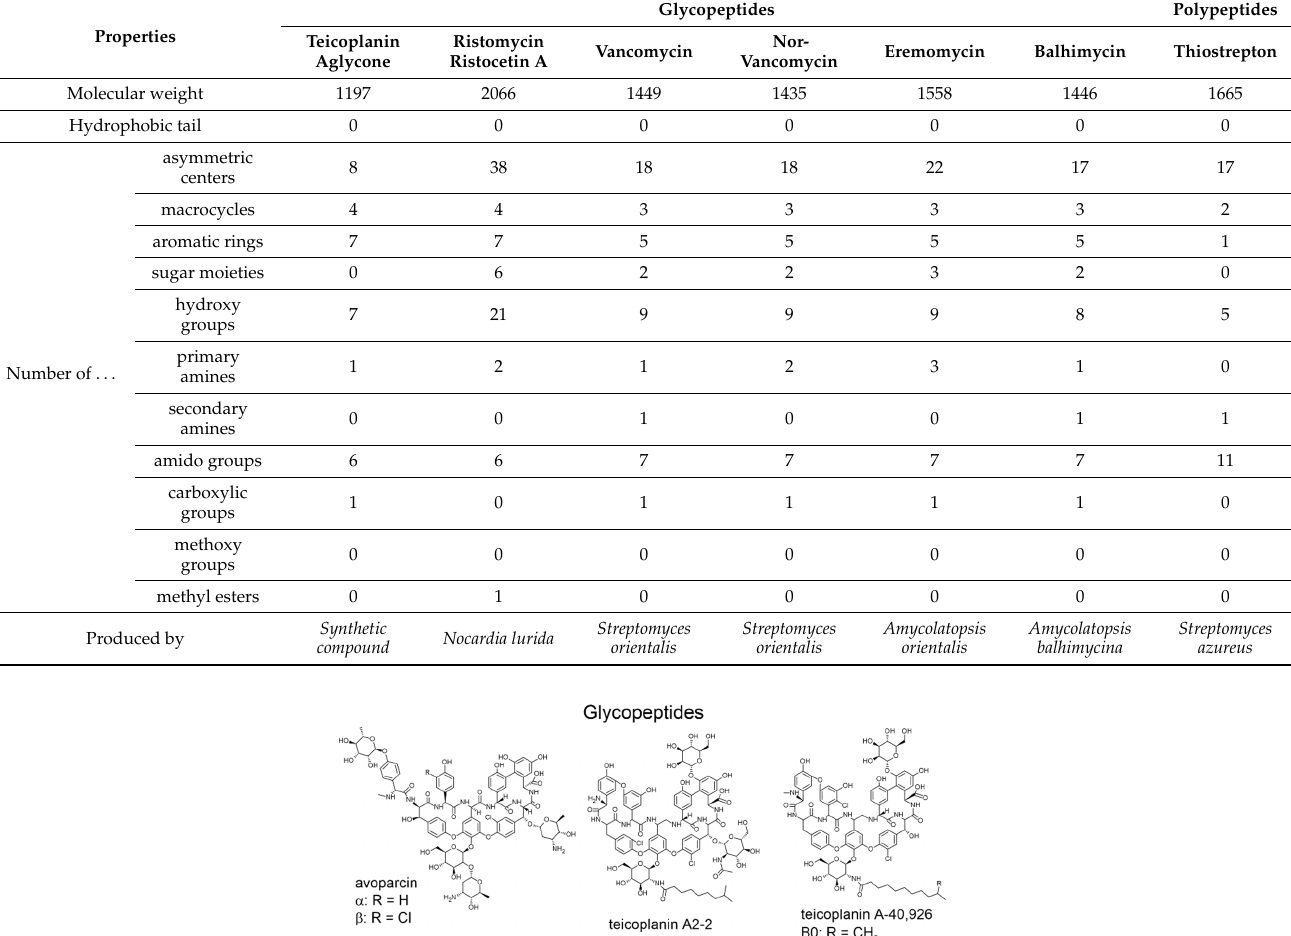
Table 2. Summary of the physico-chemical properties of macrocyclic antibiotics applied as chiral selectors [13].